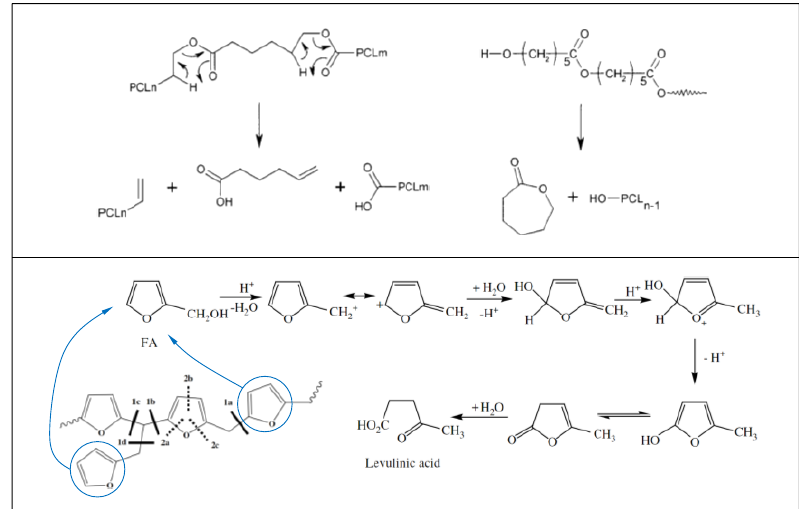
Scheme 1. Thermal degradation mechanisms of PCL (top panel). Reproduced with permission from 284 American Chemical Society [36]. Thermal degradation mechanisms of PFA (bottom panel). 285 Reproduced with permission from Elsevier [35]. 286